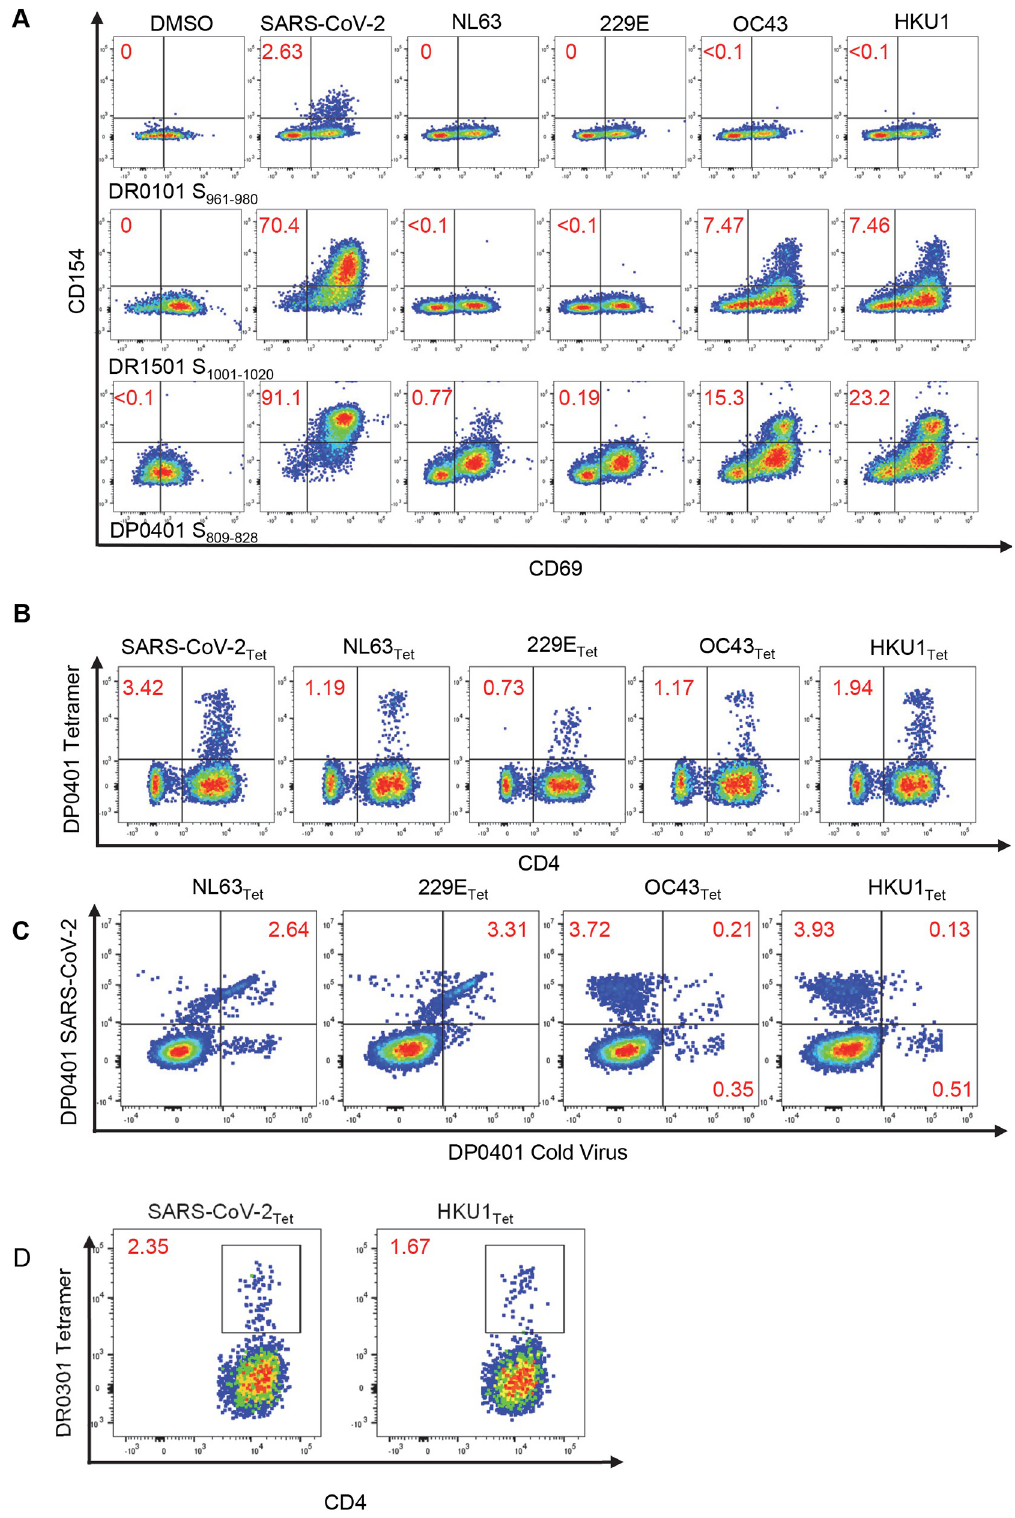
Fig 4. SARS-CoV-2 Cross-reactive T cells. (A) CD154 upregulation assay of potential cross-reactive epitopes. Top panel: DR0101 SARS- CoV-2 S 961-980 , middle panel: DR1501 SARS-CoV-2 S 1001-1020 , and bottom panel: DP0401 SARS-CoV-2 S 809- 828 . SARS-CoV-2 peptide-specific cell lines were generated and activated with peptides for five hours from SARS-CoV2 or its